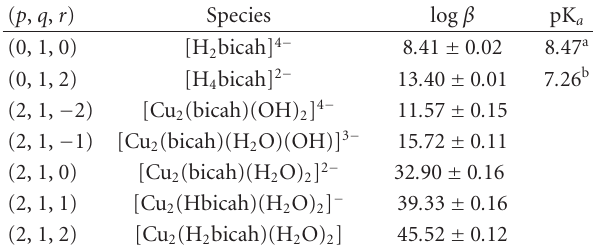
Table 2: Compositions, overall stability formation constants (log β ), and acidity constants (pK a ) for the species formed in H 6 bicah and Cu(II)- H 6 bicah system, over the pH range 2.00– 10.0 thus obtained from the potentiometric study (25 ◦ C, I